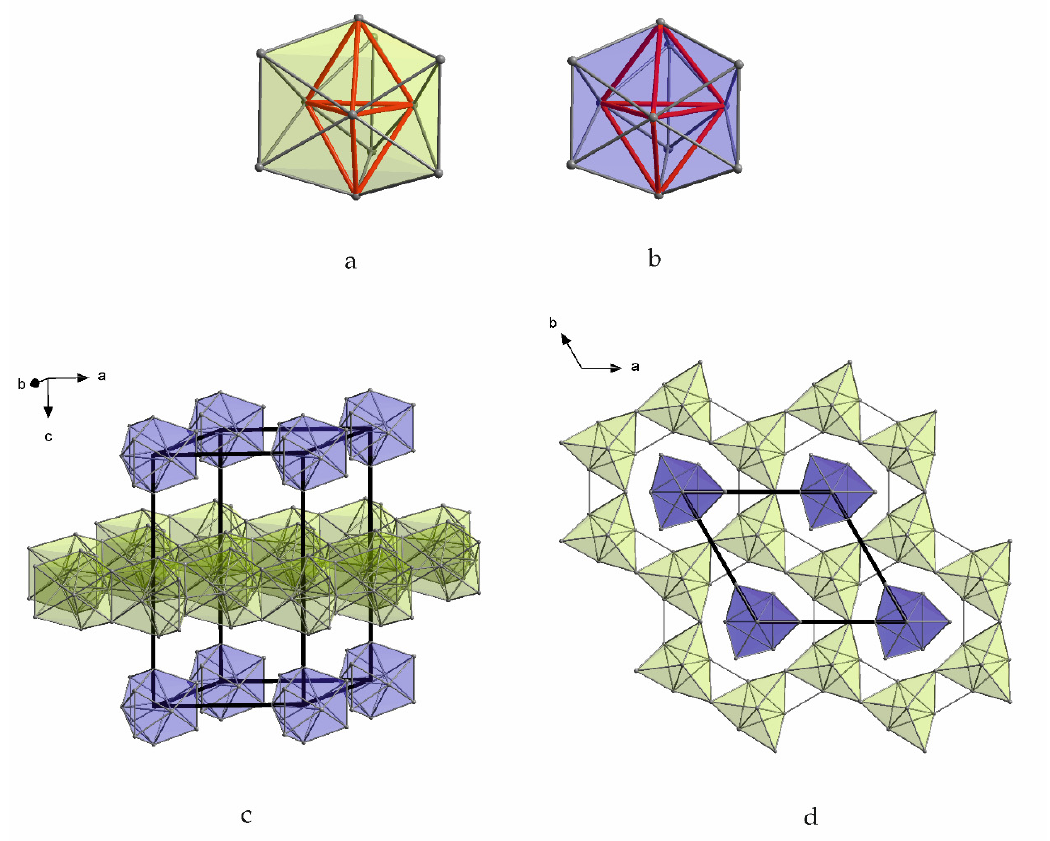
Figure 5. Thallium substructures in Rb 15 Tl 27 : ( a ) Tl 11 subunits (double tetrahedral stars) which build the Tl layer; ( b ) isolated Tl 11 7 − clusters (double tetrahedral stars); ( c , d ) isolated Tl 11 7 − clusters and layers formed by the condensation of Tl 11 subunits in the unit cell of Rb 15 Tl 27 .